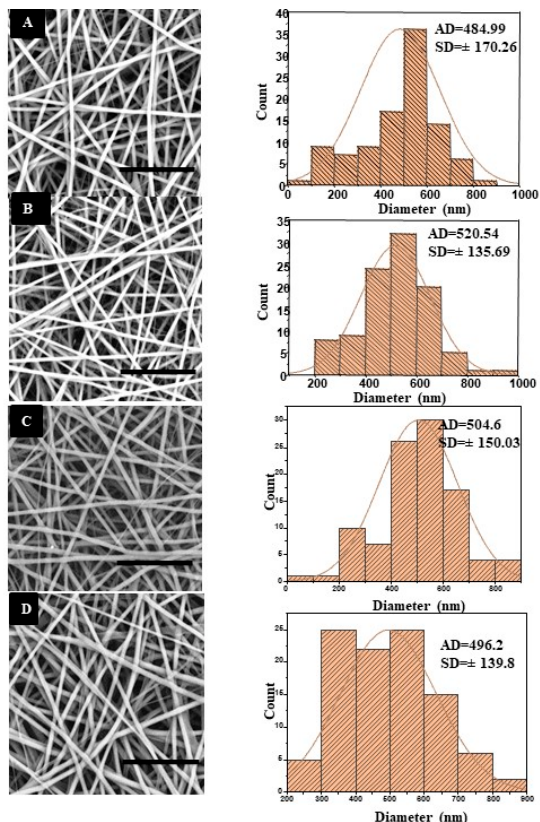
Figure 1. Scanning Electron Micrograph ( SEM) (Right) and histogram (Left), (scale bar = 20 μ m), ( A ) Poly ( l -lactic acid- co -e-caprolactone) / Silk Fibroin (PLCL / SF), ( B ) PLCL / SF / 2.5% Oregano Essential Oil (OEO), ( C ) PLCL / SF / 5% OEO, ( D ) PLCL / SF / 7.5% OEO.